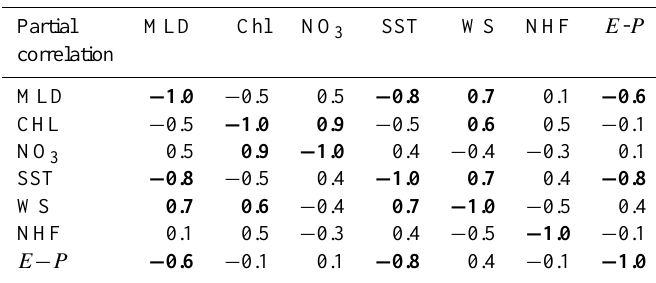
Table 2. Partial correlation among MLD, SST, chlorophyll a (Chl), nitrate (NO 3 ) , WS, NHF, and E - P . Values greater than 0.5 are in boldface.